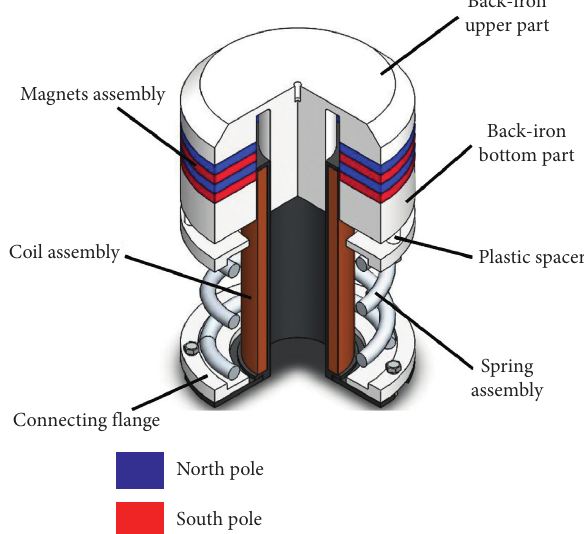
Figure 5: Back-iron design-based electromagnetic TMD